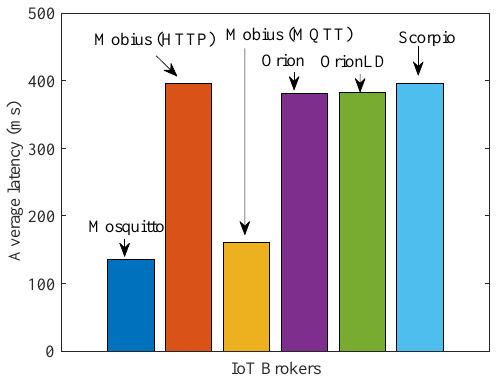
Figure 16. Average latency for test scenario 3 (remote-consumers).